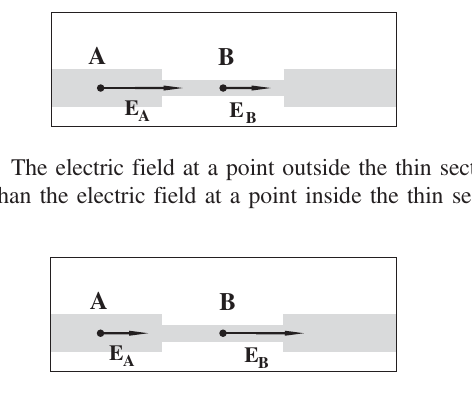
FIG. 8. The electric field at a point outside the thin section is less than the electric field at a point inside the thin section.